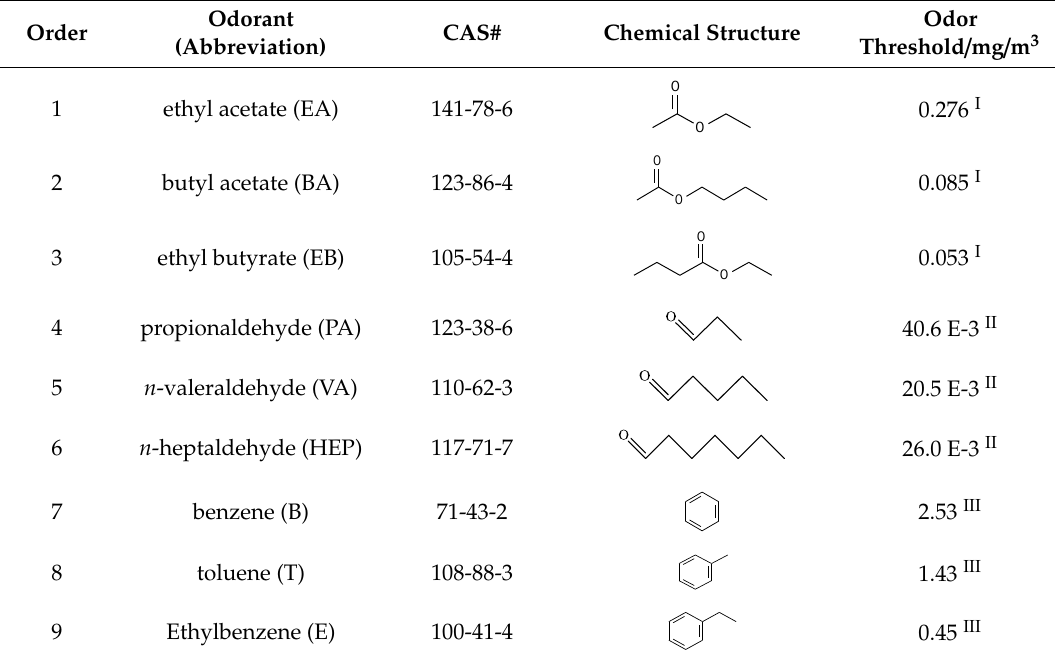
Table 1. List of odorants and their odor thresholds.